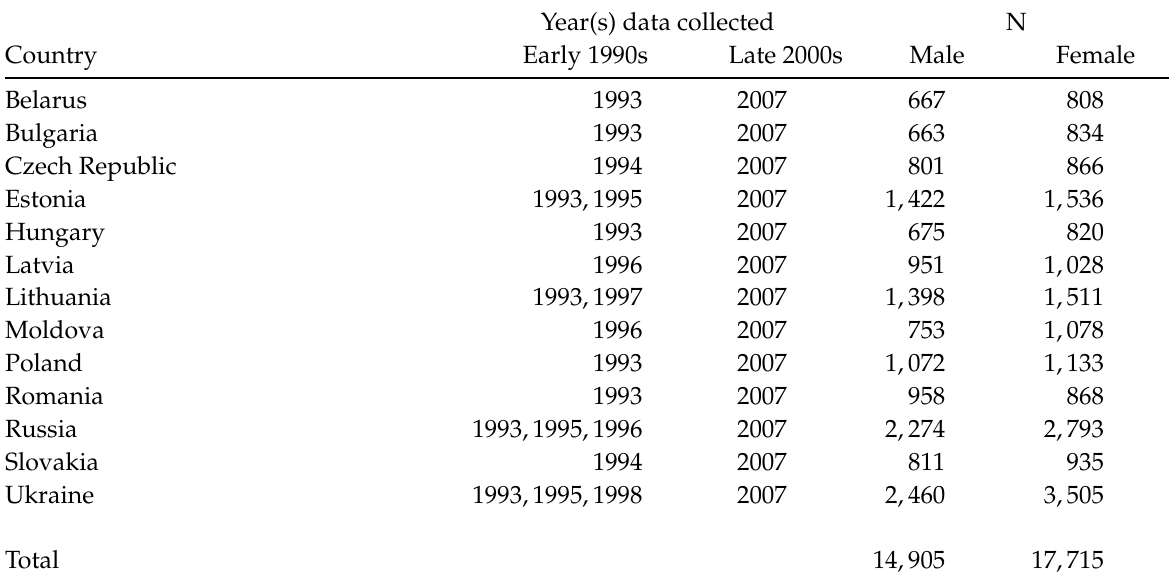
Table 1: Data information for each